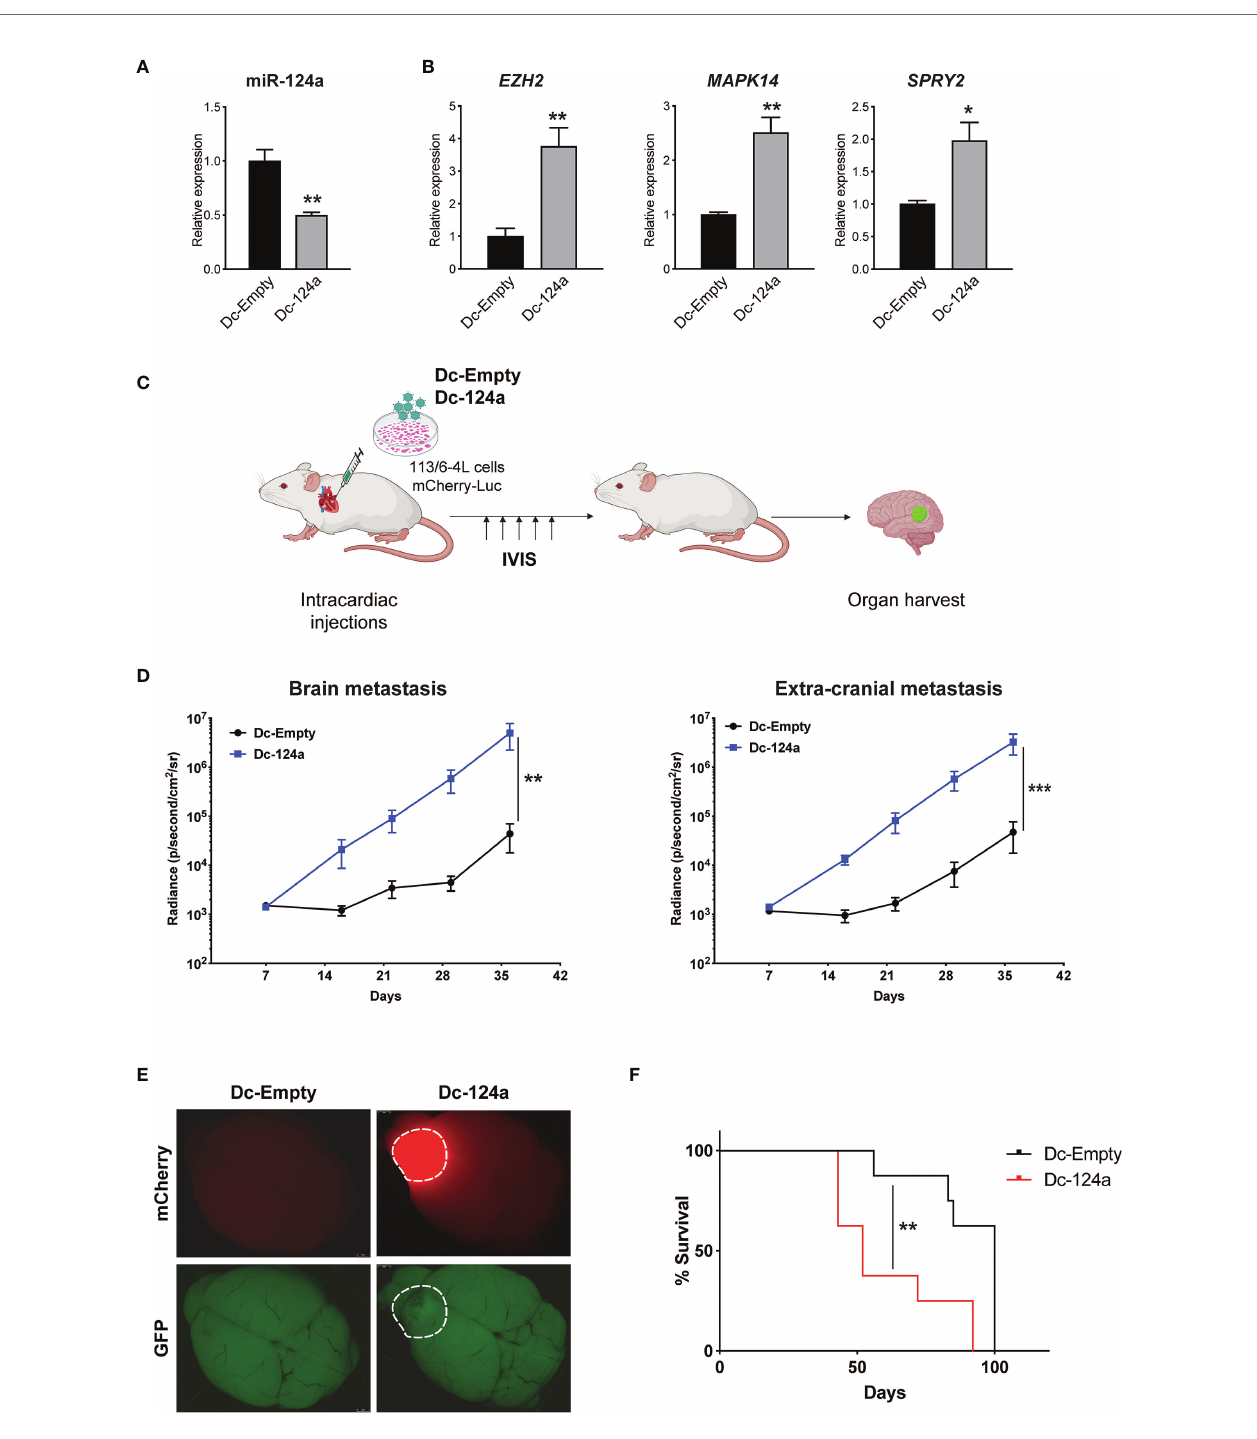
FIGURE 2 | miR-124a silencing enhances melanoma metastasis. (A) Relative expression of miR-124a (unpaired t test; **p = 0.003) and (B) its targets was measured by quantitative RT-PCR after lentiviral infection of 113/6-4L with mCherry-Luciferase and Dc-Scr or Dc-124a tagged with a GFP reporter (unpaired t test; EZH2 **p = 0.0019, MAPK14 **p = 0.0059, and SPRY2 *p = 0.0189). (C) Schematic representation of the in vivo metastasis model in athymic/nude female mice (n = 8 per group). (D) miR-124a silencing signi fi cantly accelerates both brain (**p = 0.0069) and extracranial metastasis (***p = 0.001) burden, as measured by in